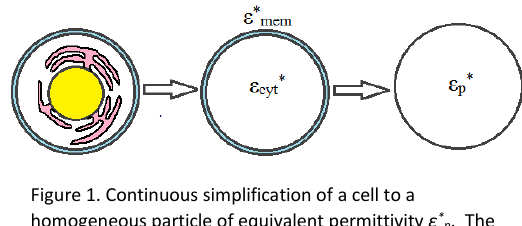
Figure 1. Continuous simplification of a cell to a homogeneous particle of equivalent permittivity ɛ *p . The cell is represented as cytoplasm covered by a membrane with complex permittivities ɛ *cyt and ɛ *mem , respectively